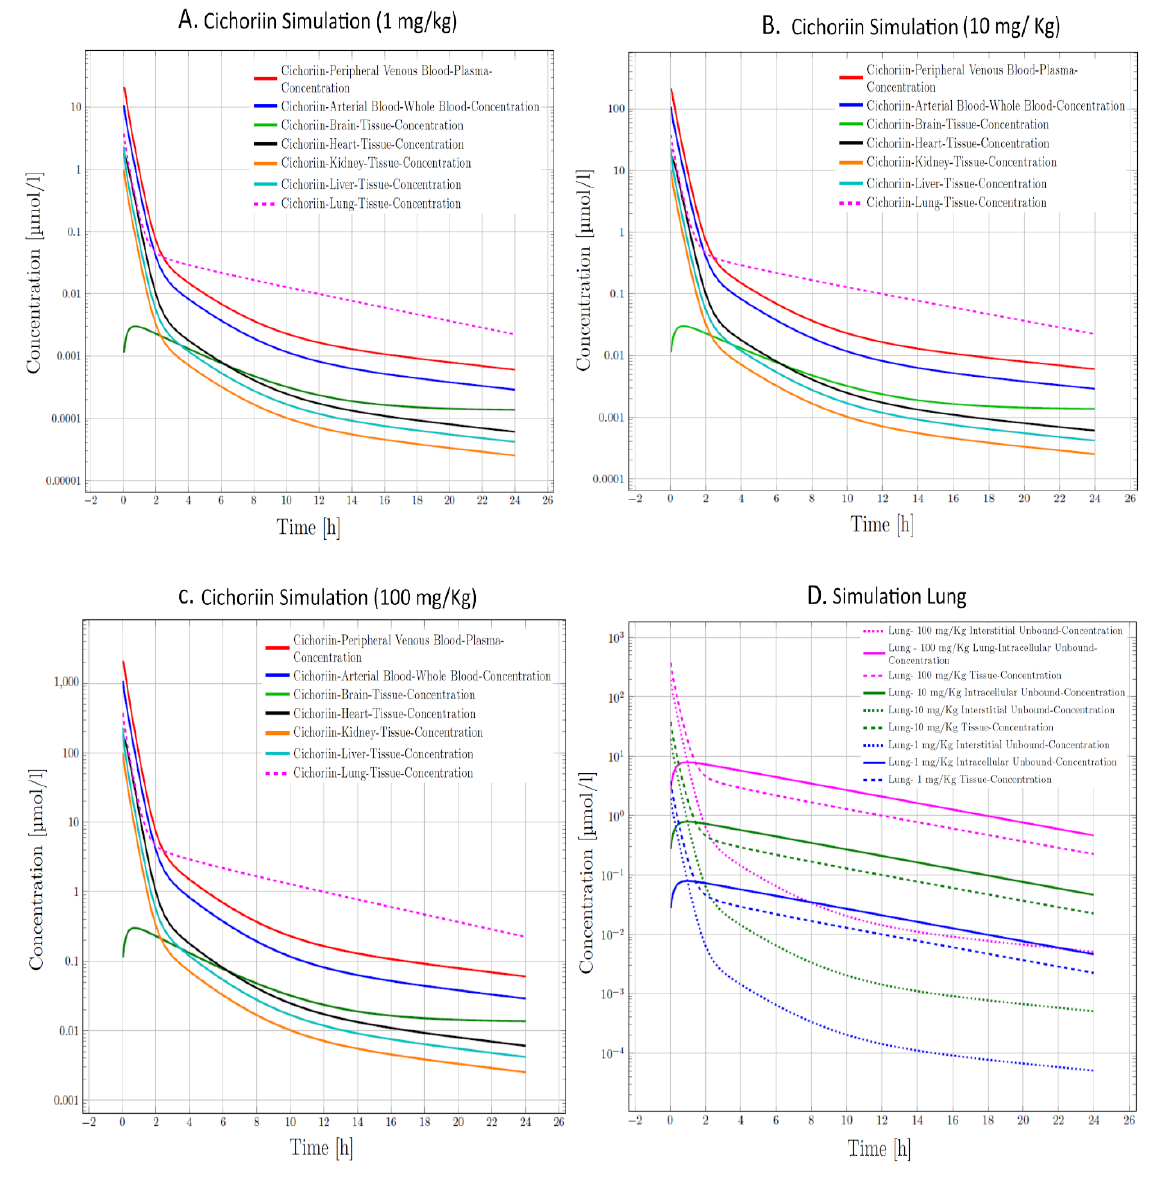
Figure 5. Physiologically based pharmacokinetic model (PBPK) simulation of Cichoriin IV at three concentrations. ( A ) 1 mg/kg, ( B ) 10 mg/kg, ( C ) 100 mg/kg. ( D ) Cichoriin kinetics in the lung with the three selected concentrations, suggesting that the best dose is 100 mg/kg IV (pink).